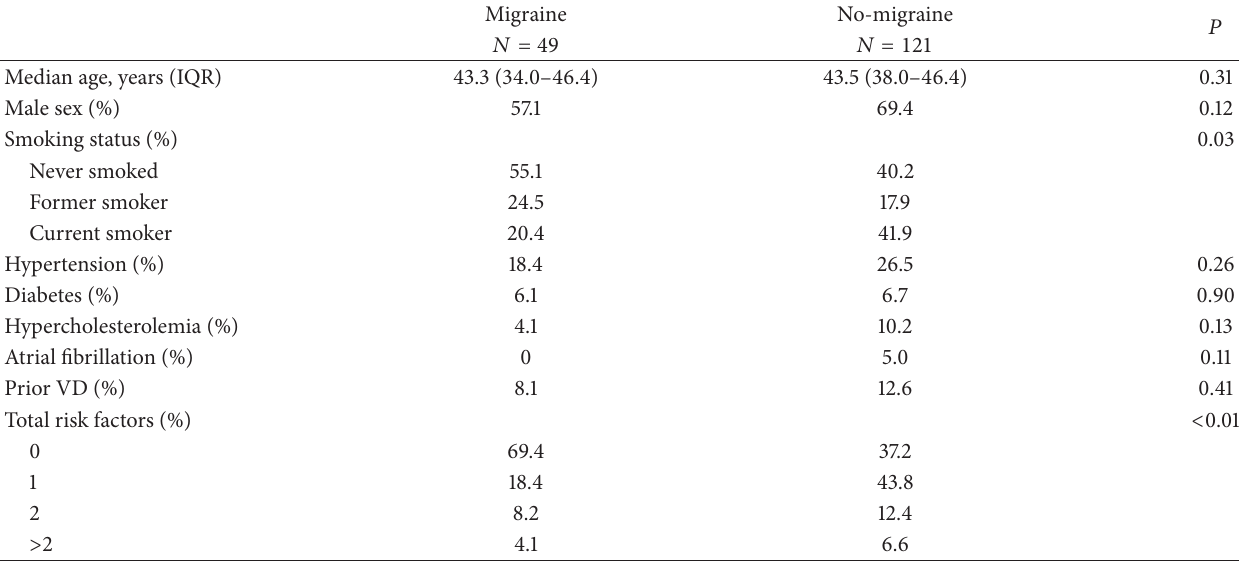
Table 1: Demographic characteristics of young ischaemic stroke patients with and without migraine.